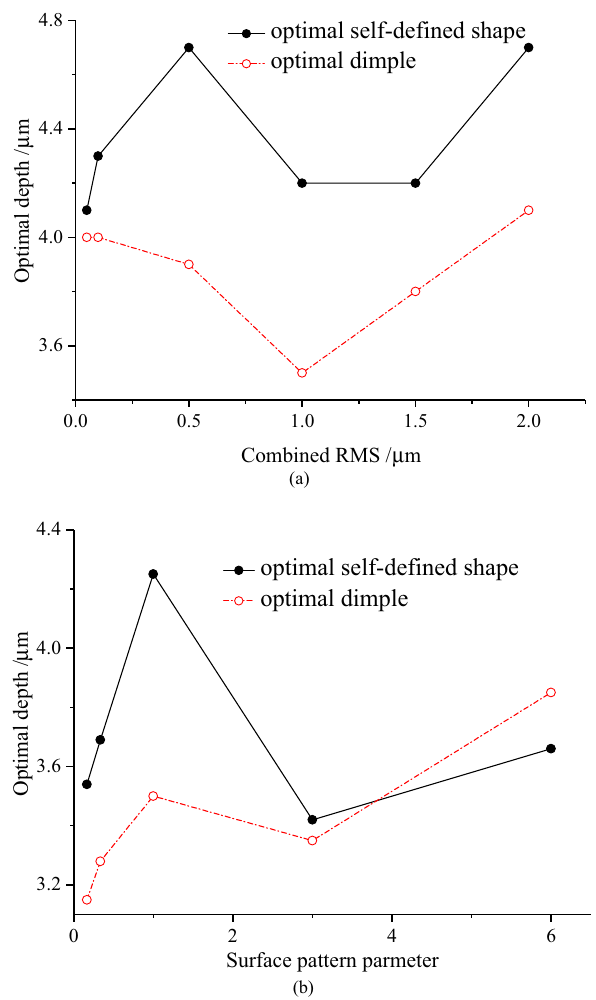
Figure 6. ( a ) Variation of the optimal depth with combined RMS; ( b ) variation of the optimal depth with surface pattern